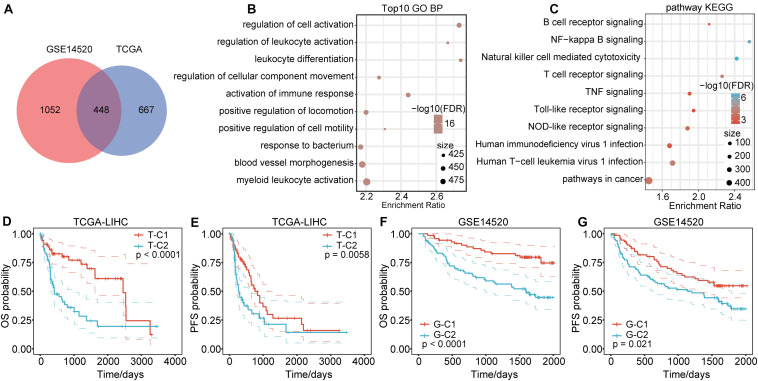
Functional enrichment pathways of immune-related genes and differential prognosis between immune subtypes. (A) Venn diagram of immune co-expression-related genes. (B) GO function annotation for BPs of immune score–related genes. (C) KEGG analysis of immune score-related genes. (D,E) The immune subtypes T-C1 and T-C2 in TCGA have significant differences in OS and PFS time. (F,G) The immune subtypes G-C1 and G-C2 in GSE14520 have significant differences in OS and RFS time.